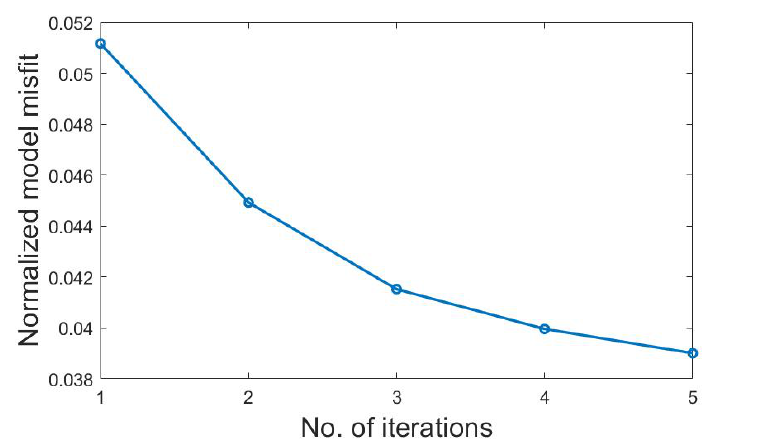
Figure 8. The normalized model misfit versus the No. of iterations in the training